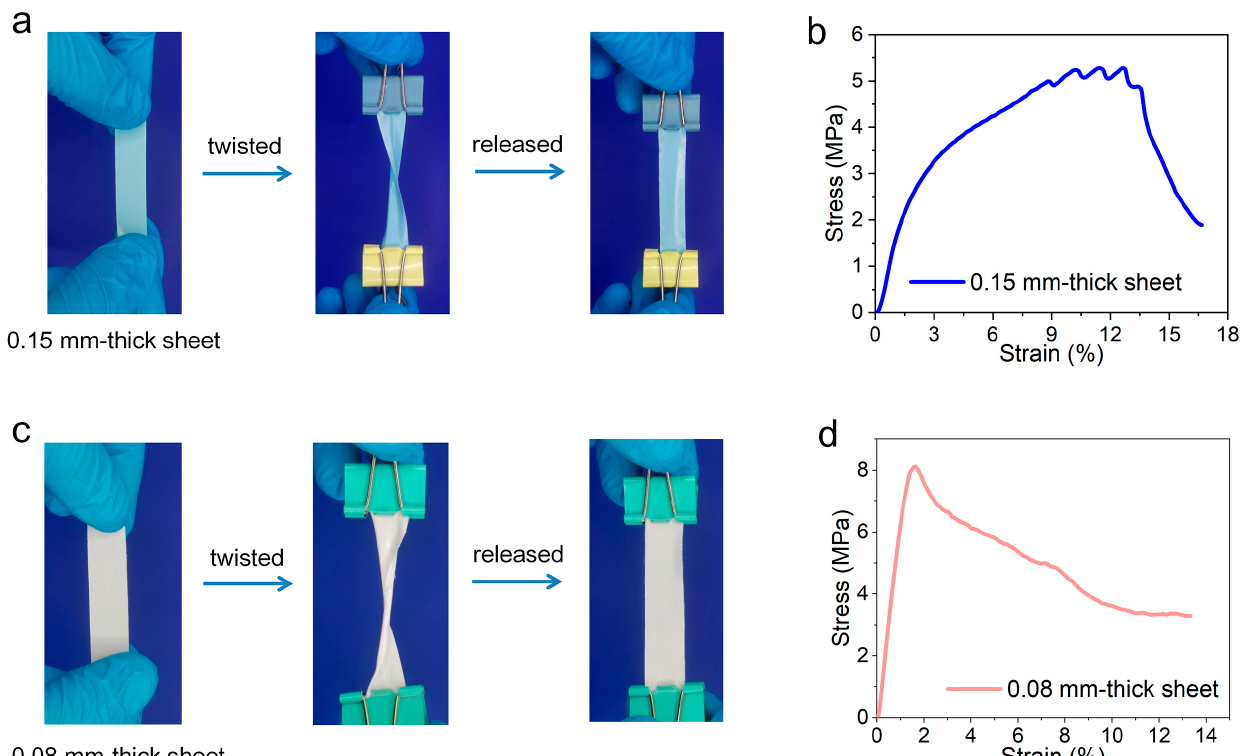
Figure 3. ( a ) Photographs showing the high flexibility of 0.15 mm-thick sheets prepared by the conventional method. ( b ) Typical tensile curve of 0.15 mm-thick sheets. ( c ) Photographs showing the high flexibility of 0.08 mm-thick sheets prepared by the low-viscosity calendering method; ( d ) Typical tensile curve of 0.08 mm-thick sheets.